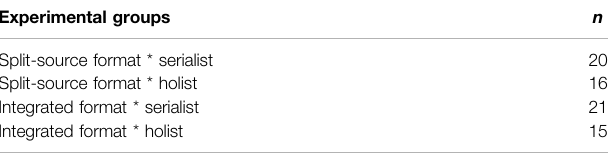
TABLE 4 | Number of participants in each experimental group of study